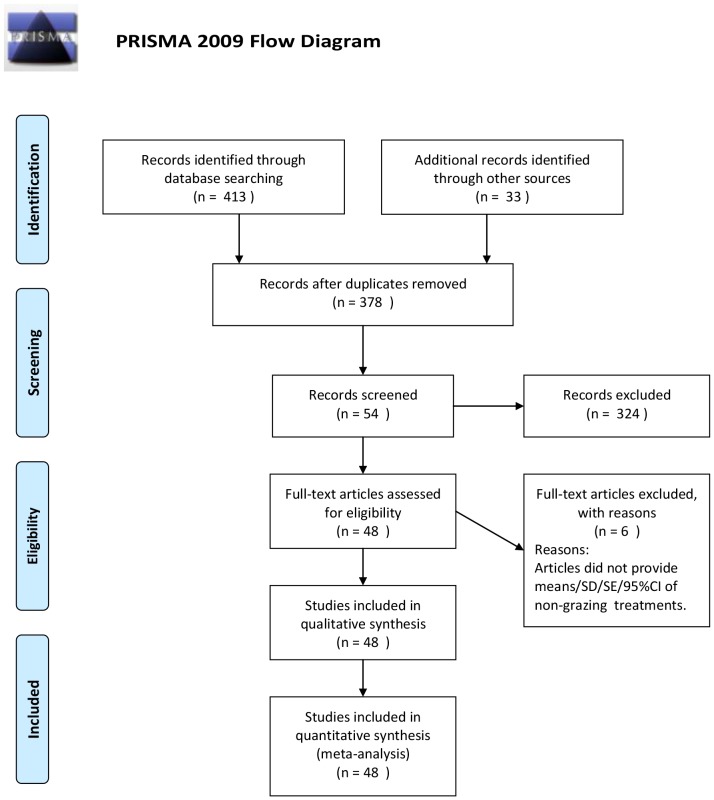
The flow diagram.